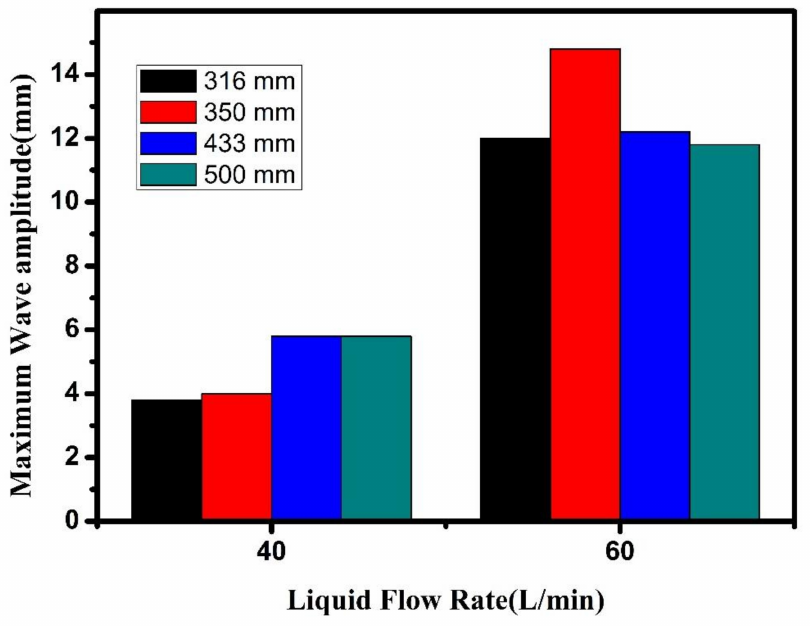
Figure 8. Effect of section sizes (mould width) on maximum surface wave amplitude for 15 ◦ downward port under different operating